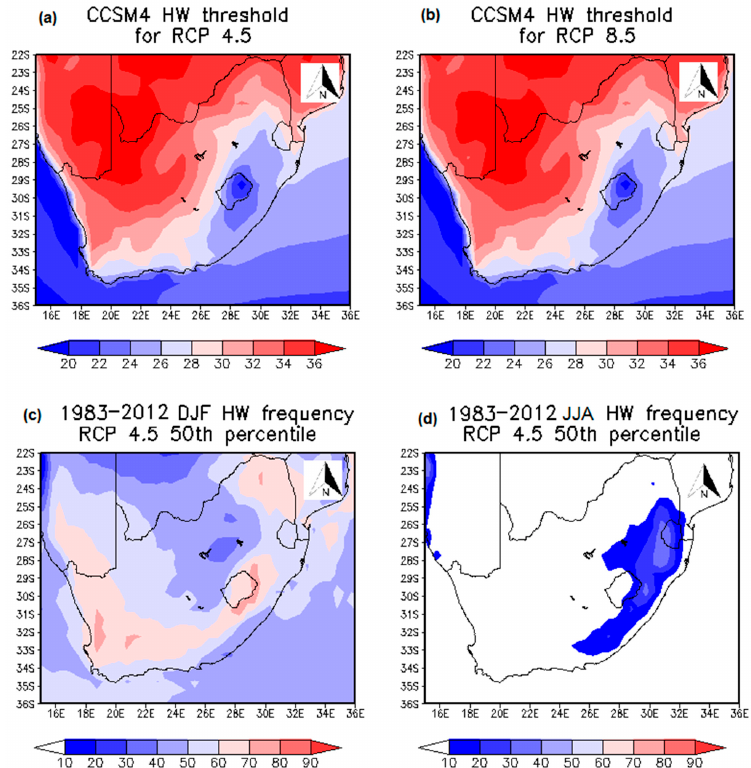
Figure 6. Simulations of HW thresholds ( ◦ C) for ( a ) CCSM4 RCP 4.5, ( b ) RCP 8.5 and RCP 4.5 scenario HW frequency (total number of occurrence) during the present-day climate, ( c ) 1983–2012 DJF and ( d ) JJA.